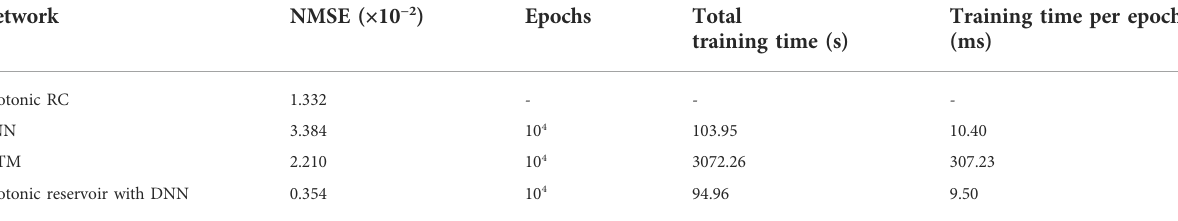
TABLE 2 NMSE and time used for training the different simulated network models, on the Santa Fe one-step ahead prediction task.